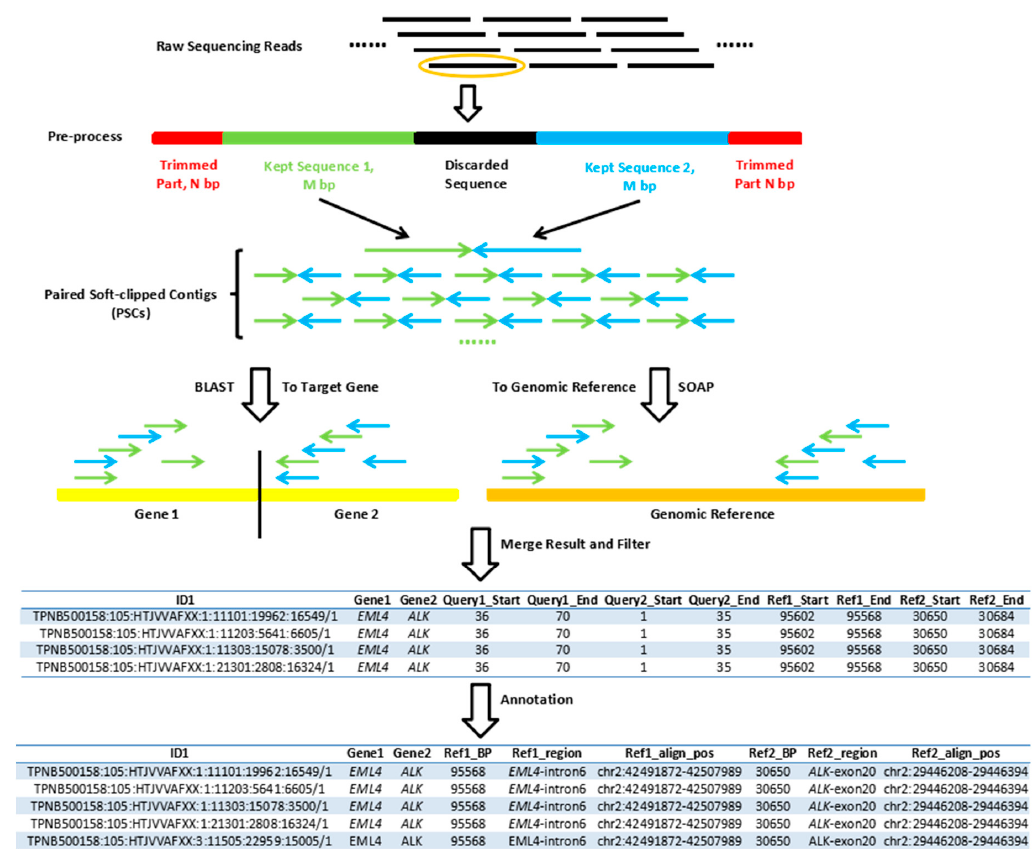
Figure 1. The scheme shows how the single-end gene fusion (SEGF) works. Firstly, there is pre- processing of raw sequencing data, including trimming of the first and last N bp (red part) and merging the first and last M bp of the remaining sequence as paired soft-clipped contigs (PSCs) (green and blue part); the last remaining part (black part) was discarded, and not used in the following analysis. Basic local alignment search tool (BLAST) and Short Oligonucleotide Analysis Package (SOAP) were used to align PSCs into target gene references (yellow part) and genomic references (orange part) separately, keeping the result unique and fully mapped to reduce the influence of genomic repetitive regions. The mutual sequences of the two filtered results are considered as fusion sequences. If the number of mutual reads was larger than three, then the sample was considered as fusion positive, otherwise, fusion negative.